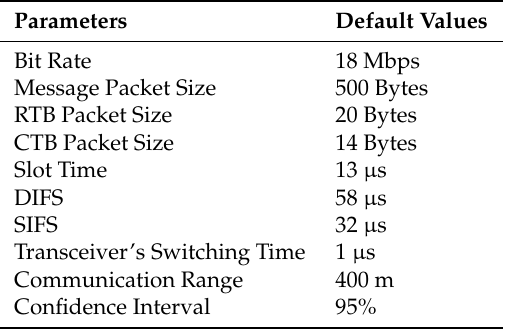
Table 2. Major communication